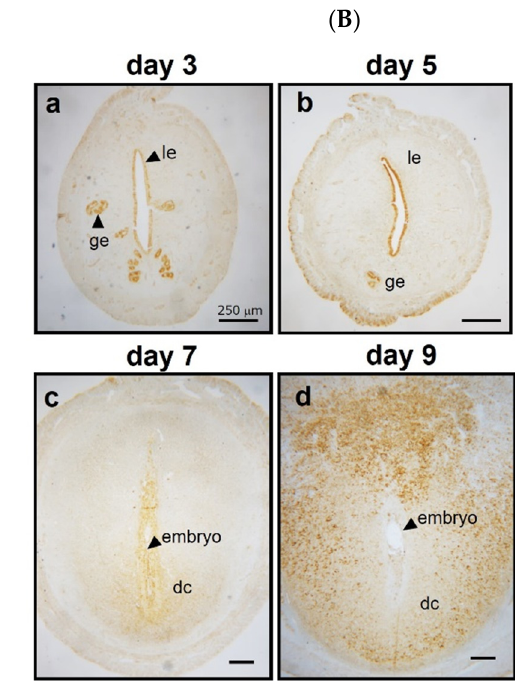
Figure 1. Expression of calreticulin (CALR) in the peri-implantation uterus of rats. Immunoblot analysis of CALR in the rat uterus on the indicated days of pregnancy ( A ). CALR levels were normalized to those of β -actin. Data represent the mean ± SEM ( n = 3). * p < 0.01 versus day 3. Immunolocalization of CALR in the pregnant rat uterus ( B ); le, luminal epithelial cells; ge, glandular epithelial cells; s, stromal cells; dc, decidual cells. Scale bars = 250 μ m.